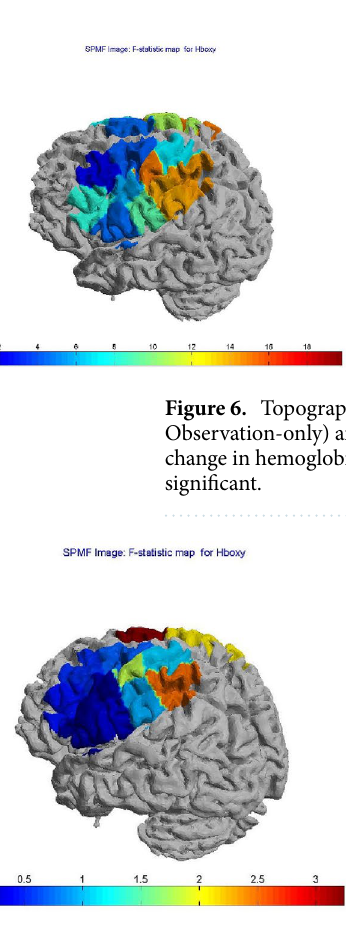
Figure 7. Topographic maps of F-statistic in the comparison among groups (FM patients vs controls) and conditions (Resting State vs Grasping Flat vs Grasping Sharp-tip object). Blue areas represent channels with no significant change in hemoglobin levels, red areas represent channels where the variations in hemoglobin levels were significant.